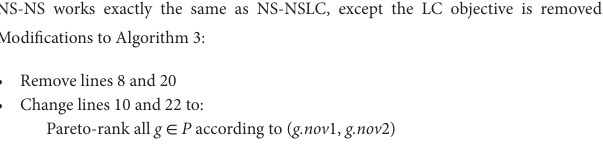
algorithm 5 | Multi-Bc MaP-elites + novelty